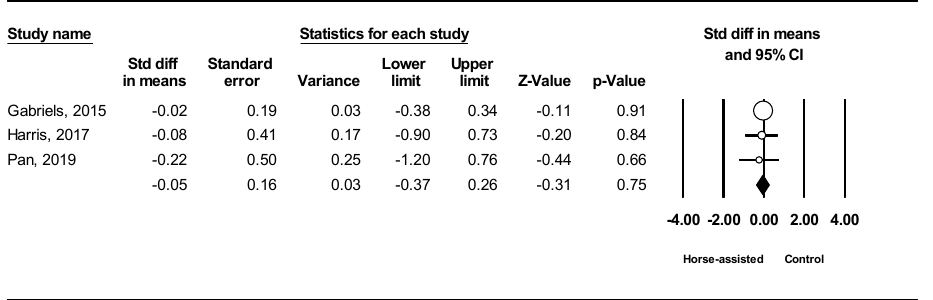
Figure 7. Forest plot showing the effects of horse-assisted therapy vs. control on stereotypy [44–46]. Among the five studies included, the pooled meta-analysis results from the three studies in Figure 8 showed that horse-assisted therapy produced a significantly positive effect on lethargy in children with ASD (SMD = − 0.32, 95% CI [ − 0.64, − 0.001], p = 0.049).